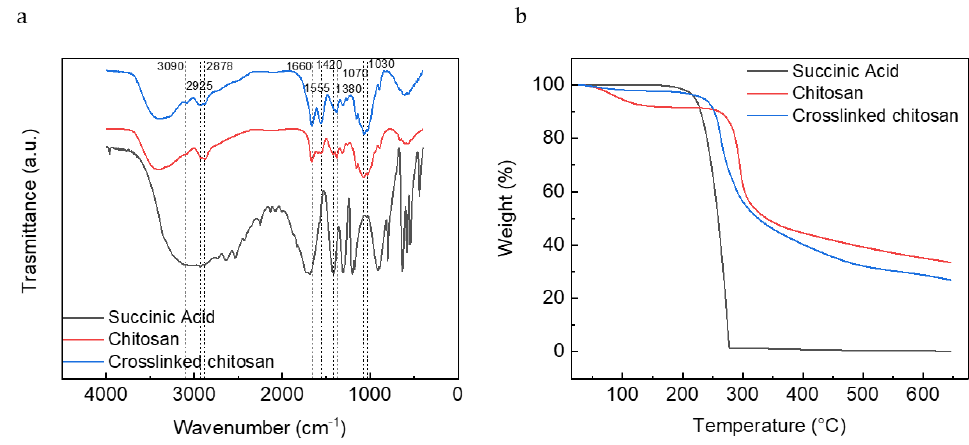
Figure 4 . ( a ) IR spectra and ( b ) TGA curves of succinic acid, chitosan, and crosslinked chitosan .